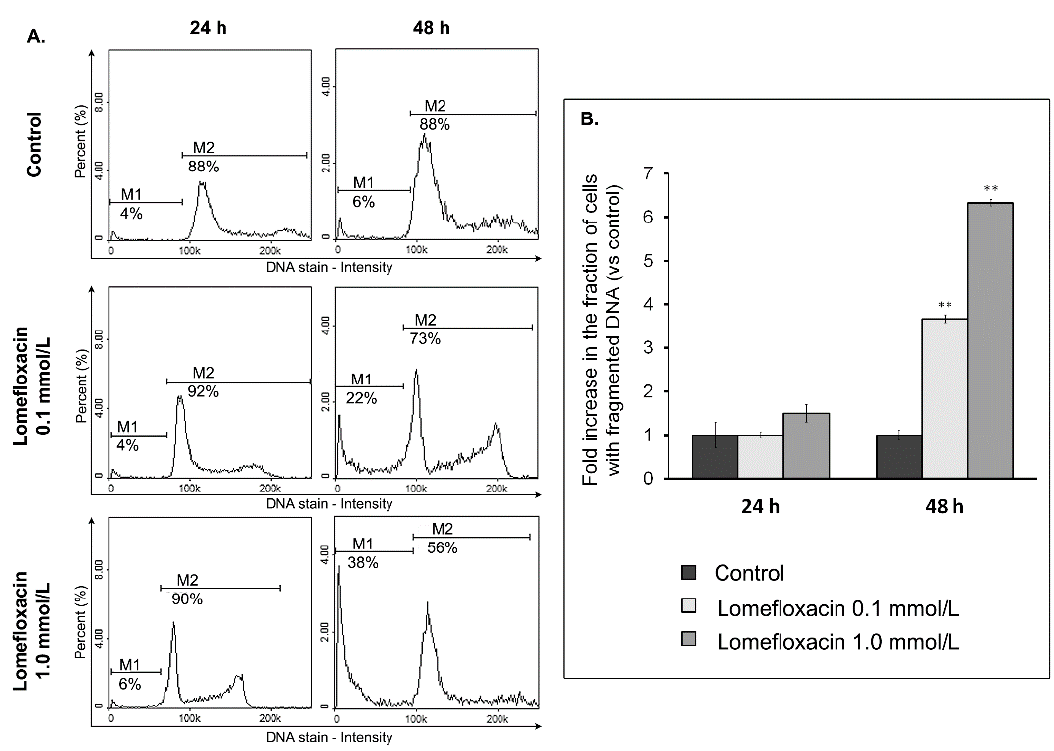
Figure 6. Lomefloxacin induces DNA fragmentation in COLO829 melanoma cells. ( A ) Histograms presenting the induction of DNA fragmentation in cells exposed to lomefloxacin at concentrations of 0.1 and 1.0 mmol/L for 24 and 48 h. The presented histograms are representative of three independent experiments with similar results. The effect of the drug on DNA fragmentation was investigated by a fluorescence image cytometer after DAPI staining. M1—cells having less than one DNA equivalent (so-called sub-G 1 cells); M2—cells having one or more than one DNA equivalent. ( B ) The effect of lomefloxacin on DNA fragmentation in COLO829 cells. The cells were treated with lomefloxacin at concentrations of 0.1 and 1.0 mmol/L for 24 and 48 h. Mean values ± SEM from three independent experiments ( n = 3) performed in triplicate are presented. ** p < 0.005 versus control samples.